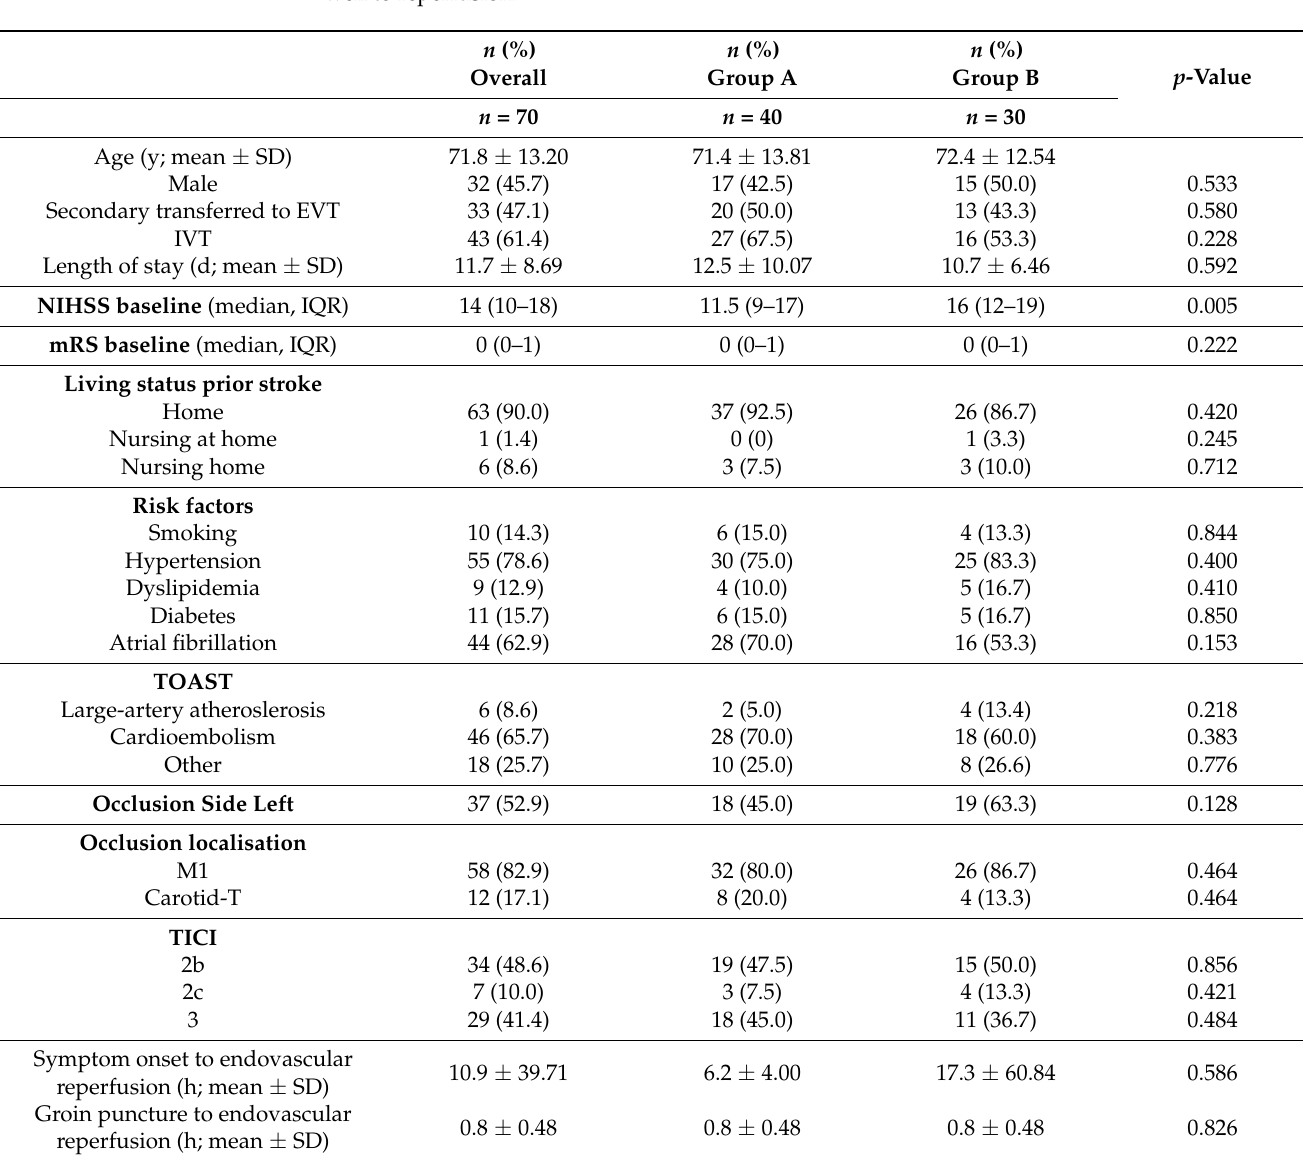
Table 1. Demographic data. Data are presented as numbers (%) or if marked as medians (IQR). NIHSS, National Institute of Health Stroke Scale; EVT, endovascular treatment; IVT, intravenous thrombolysis; TOAST, Trial of ORG 10172 in Acute Stroke Treatment; TICI, thrombolysis in cerebral infarction; symptom onset to reperfusion: time interval from witnessed symptom onset or last